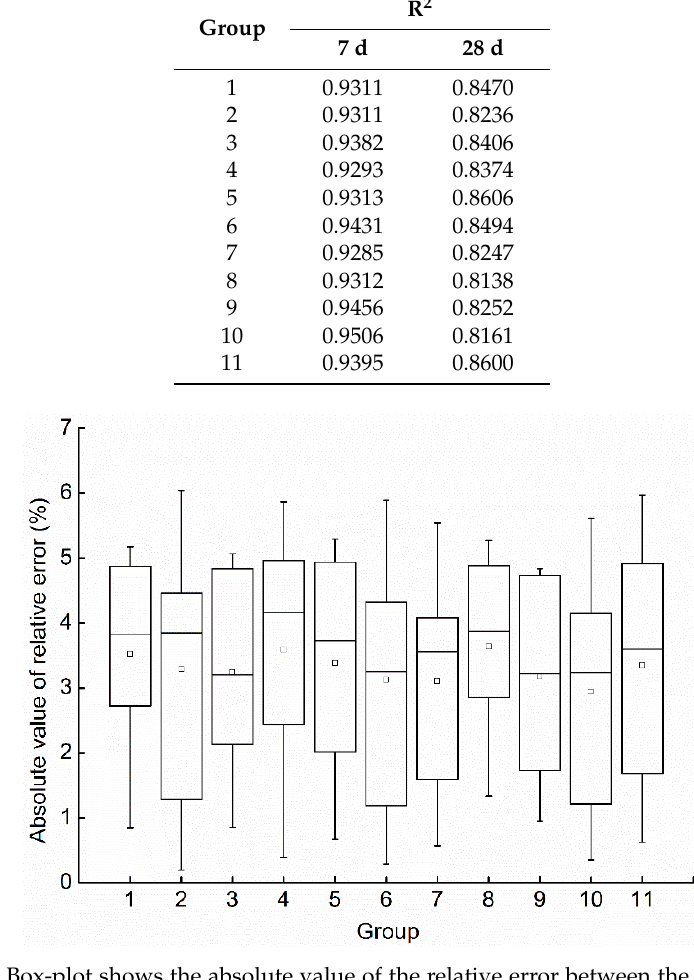
compressive strength from 10 of 11 groups randomly.